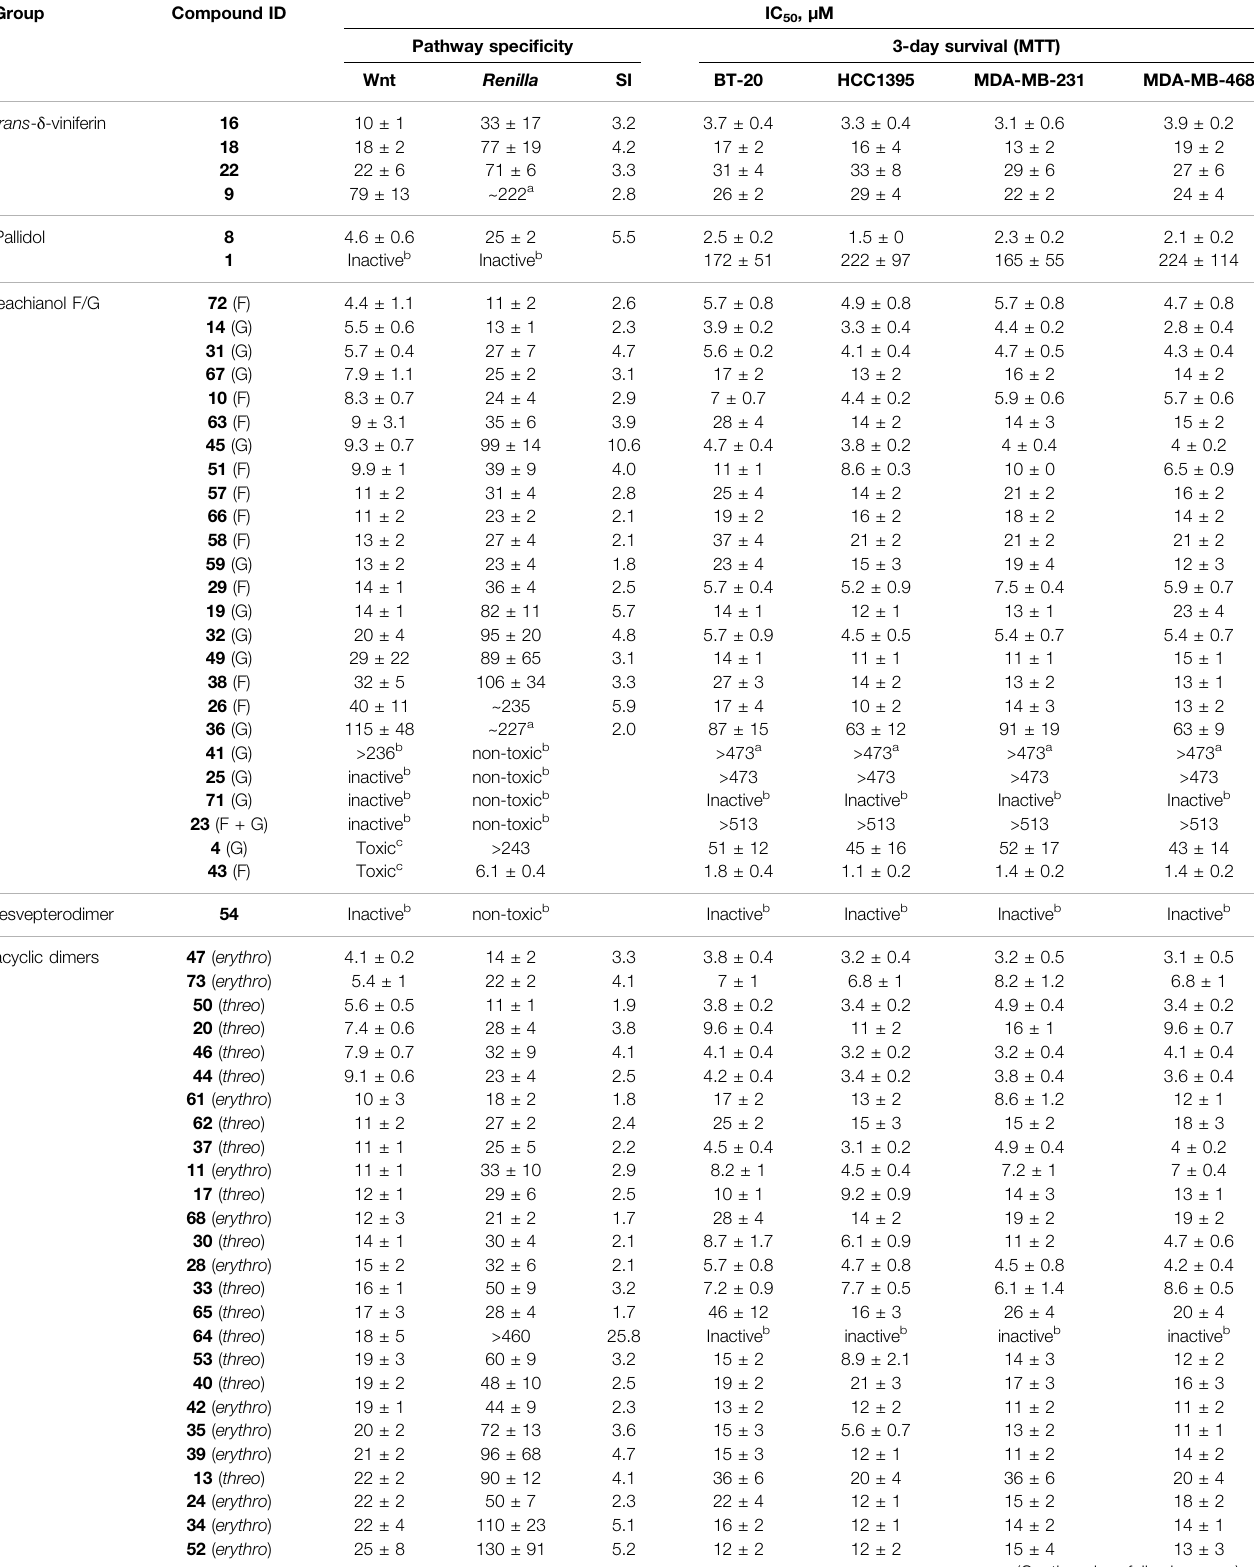
TABLE 1 | IC 50 s of the investigated compounds against Wnt pathway and breast cancer cell